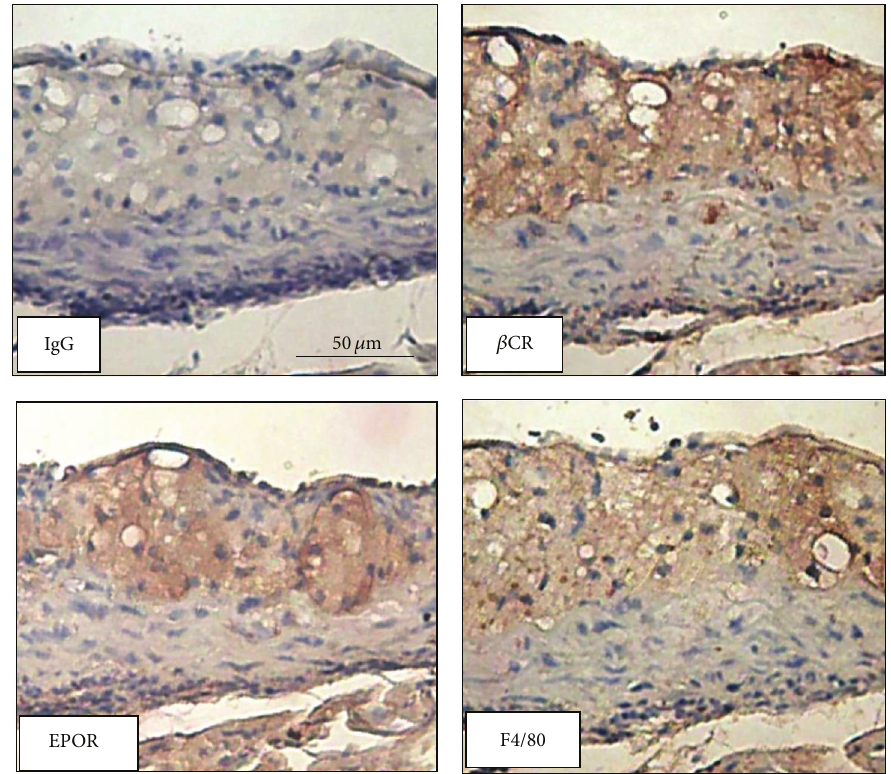
Figure 1: Expression of 𝛽 CR in atherosclerotic lesions of apoE −/− mice. Immunohistochemistry with IgG, anti- 𝛽 CR, anti-EPOR, or anti- F4/80 was performed and then recognized by the corresponding horseradish peroxidase-conjugated secondaryantibody on aortic specimens of apoE deficient mice. Hematoxylin was used as counterstaining.